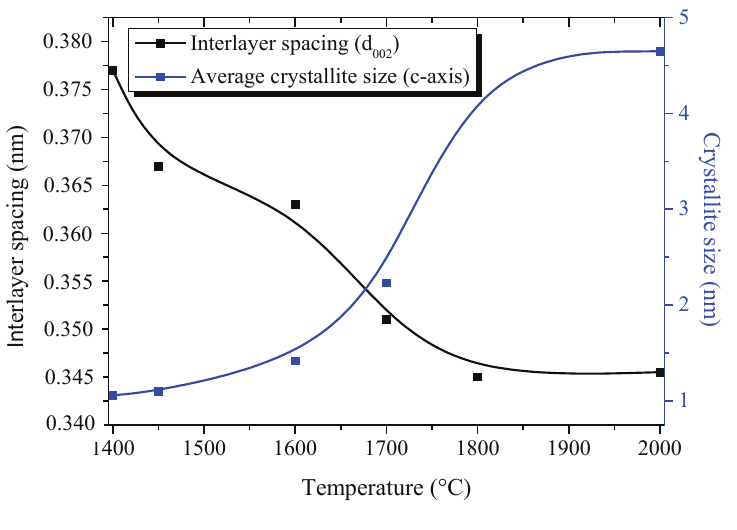
and d vs. annealing c (002) 002